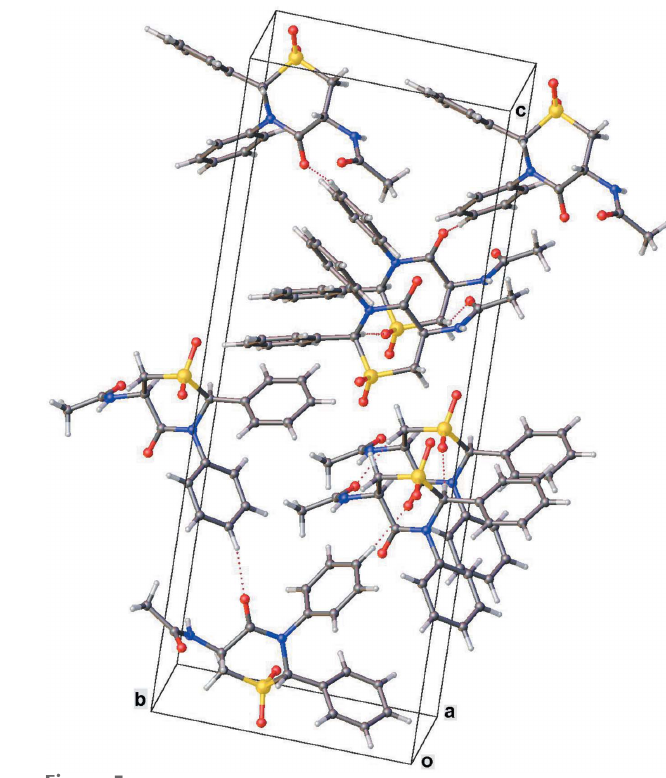
Figure 5 Crystal packing diagram for 2 showing intermolecular C—H (cid:2)(cid:2)(cid:2) O hydrogen bonds.